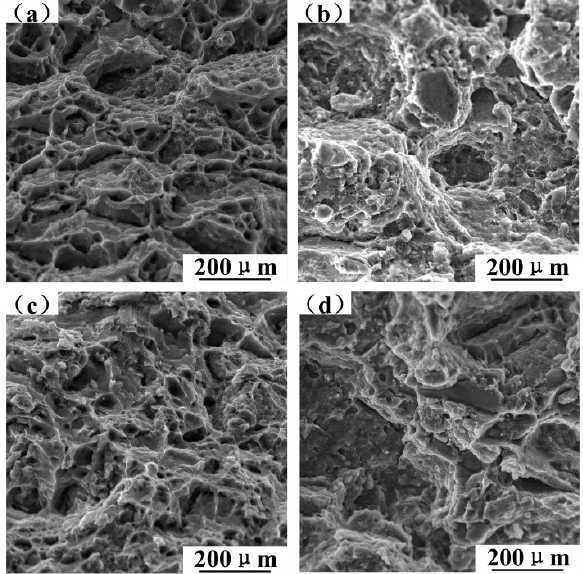
Figure 11. The fracture morphology of T6-treated composites after room temperature tensile test: ( a ) 10%SiC/6061 without T6 treatment, ( b ) T6-treated 10%SiC/6061, ( c ) 15%SiC/6061 without T6 treatment, and ( d ) T6-treated 15%SiC/6061.